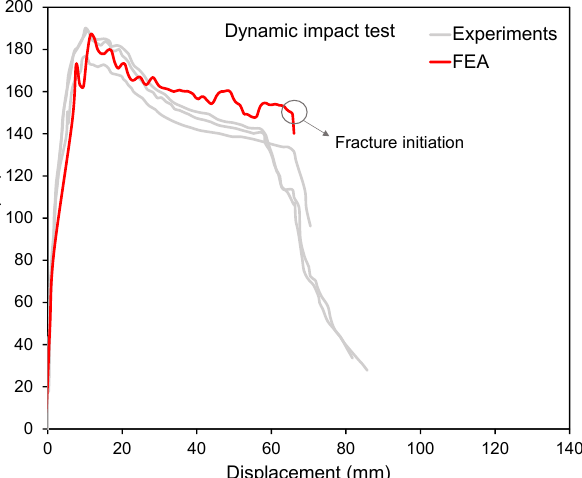
Figure 9. Comparison of the experimental and numerical force-displacement curves for the dynamic impact